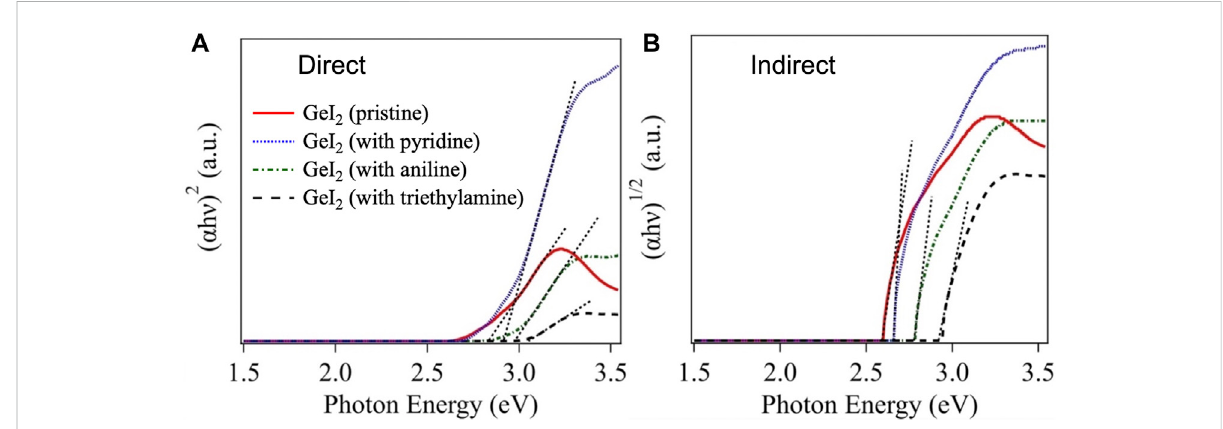
FIGURE 2 Tauc plots for extrapolation of (A) direct and (B) indirect band gaps of the pristine and intercalated GeI 2 systems. Reprinted by permission from Springer Nature (Dhingra et al., 2022a),